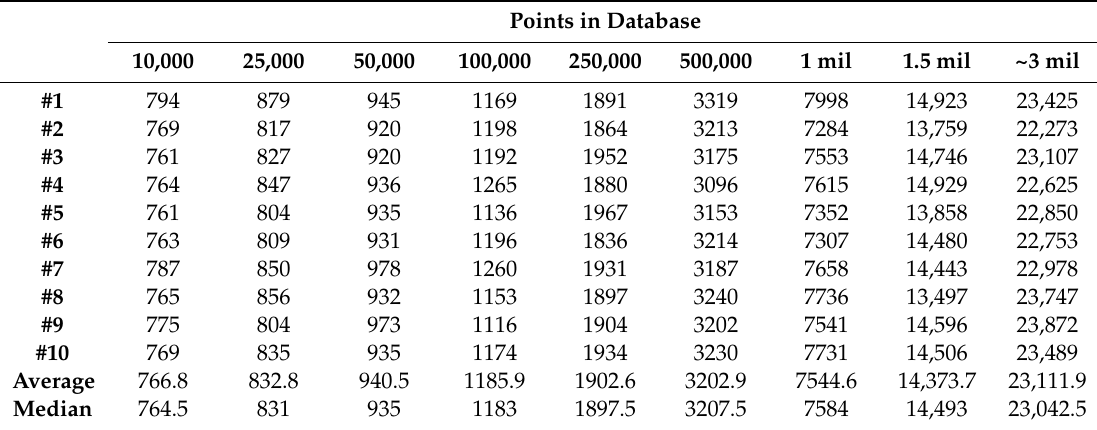
Table 6. Results of testing PruneCluster library (values in